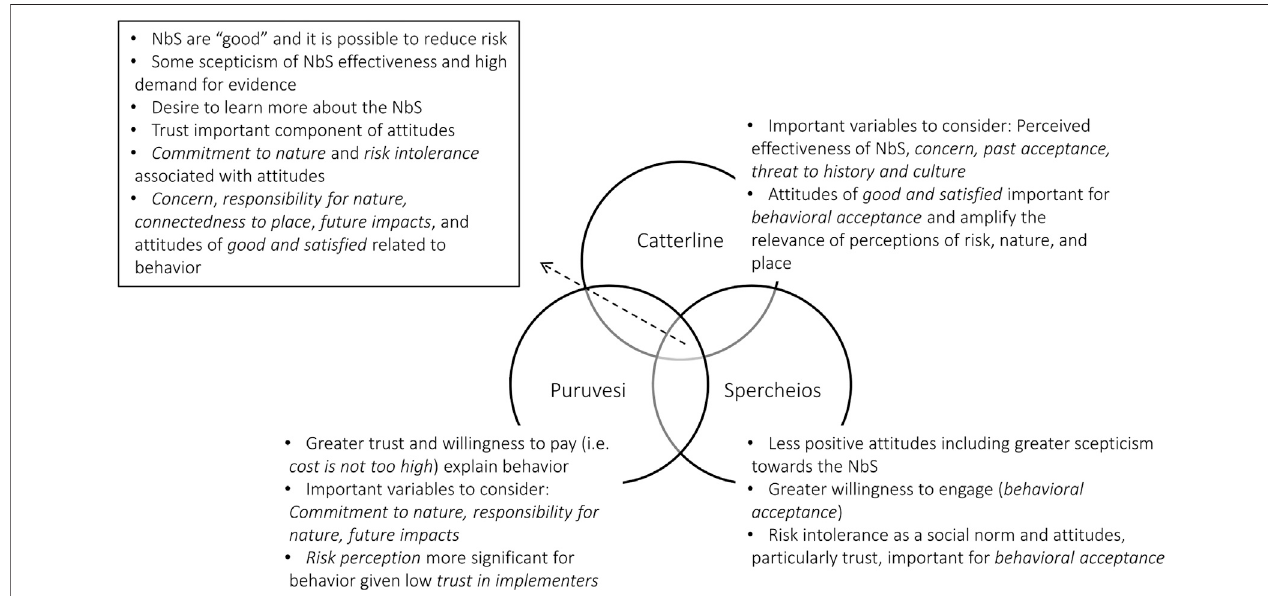
FIGURE 6 | Venn diagram of main fi ndings shared across the study sites and speci fi c fi ndings within each site.